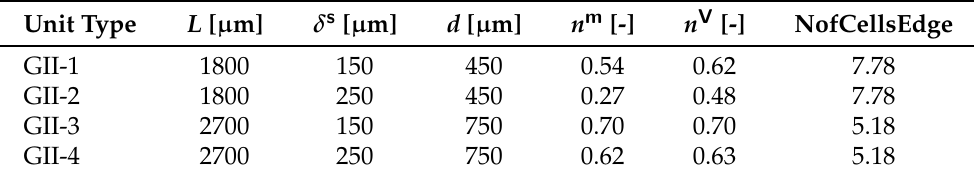
Table 3. Types and geometry of basic gyroid cell units—Phase